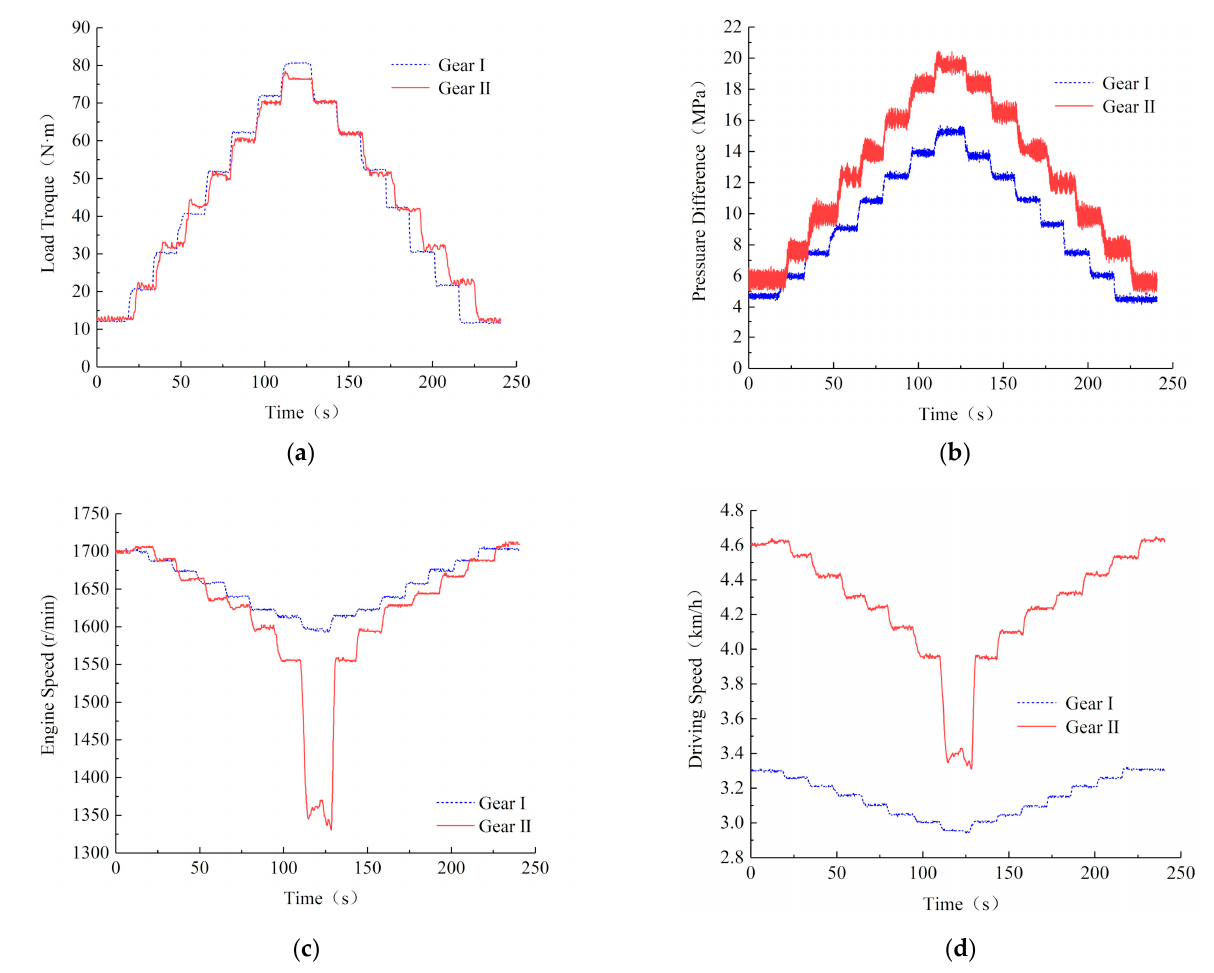
Figure 7. Test result of the traction performance. ( a ) change of the load torque; ( b ) change of the inlet and outlet pressure difference of the hydraulic motor; ( c ) change of the engine speed; and ( d ) change of the driving speed.